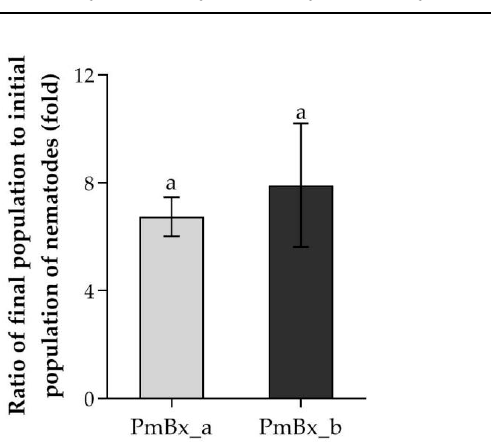
Figure 2. Population of B. xylophilus at 7 days post inoculation (dpi). Aseptic B. xylophilus (PmBx_a),